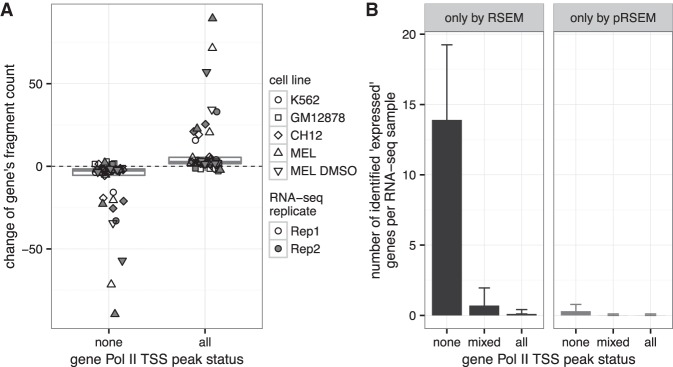
pRSEM more accurately allocates multimapping reads between genes. (A) Changes of estimated fragment counts between pRSEM and RSEM for pairs of genes overlapping with each other and sharing reads exclusively. Genes that had a fragment count change of less than one were excluded. (B) The numbers of genes for which RSEM (black) and pRSEM (gray) disagreed on expression status. Genes considered were those sharing RNA-seq reads with others but not overlapping with any other genes. The numbers were calculated from 10 RNA-seq replicates from five human and mouse cell lines. Error bars represent one standard deviation.